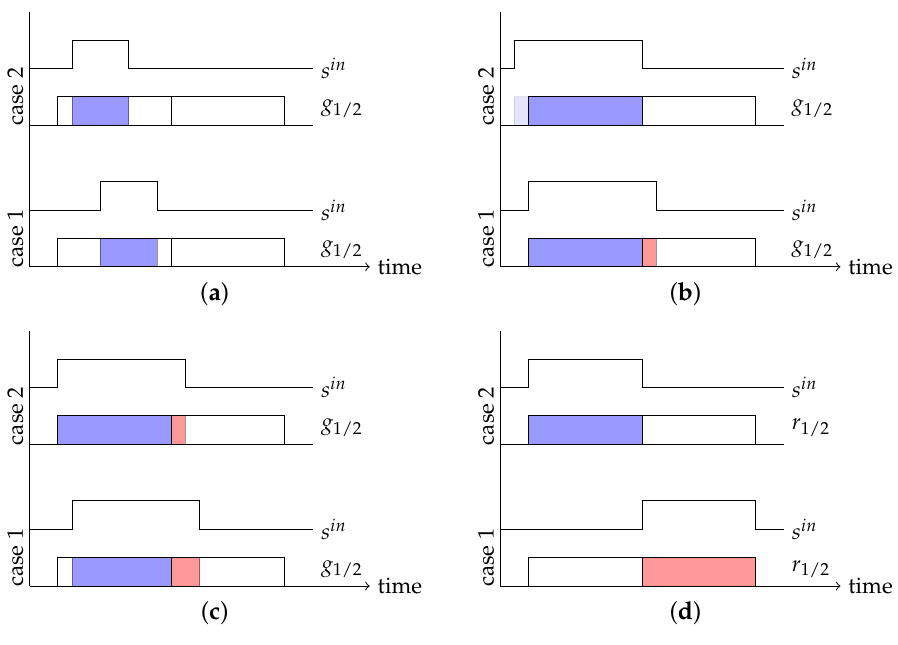
> w pulse the unambiguous range 1,2 < w pulse the g 1 ratio does g 1 + g 2 1,2 = w pulse = w the 1,2